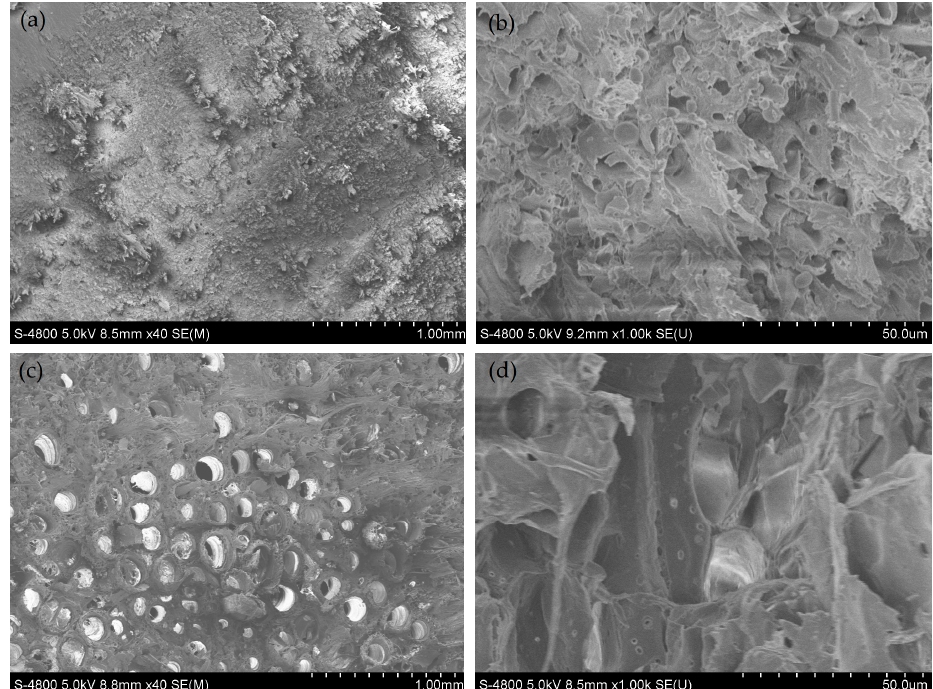
Figure 4. Electron micrographs (via SEM) of root macropores: ( a ) ( b ) internal pores of living roots (scale bars: 1 mm and 50 μ m, respectively); ( c ) ( d ) internal pores of dead roots (scale bars: 1 mm and 50 μ m, respectively).